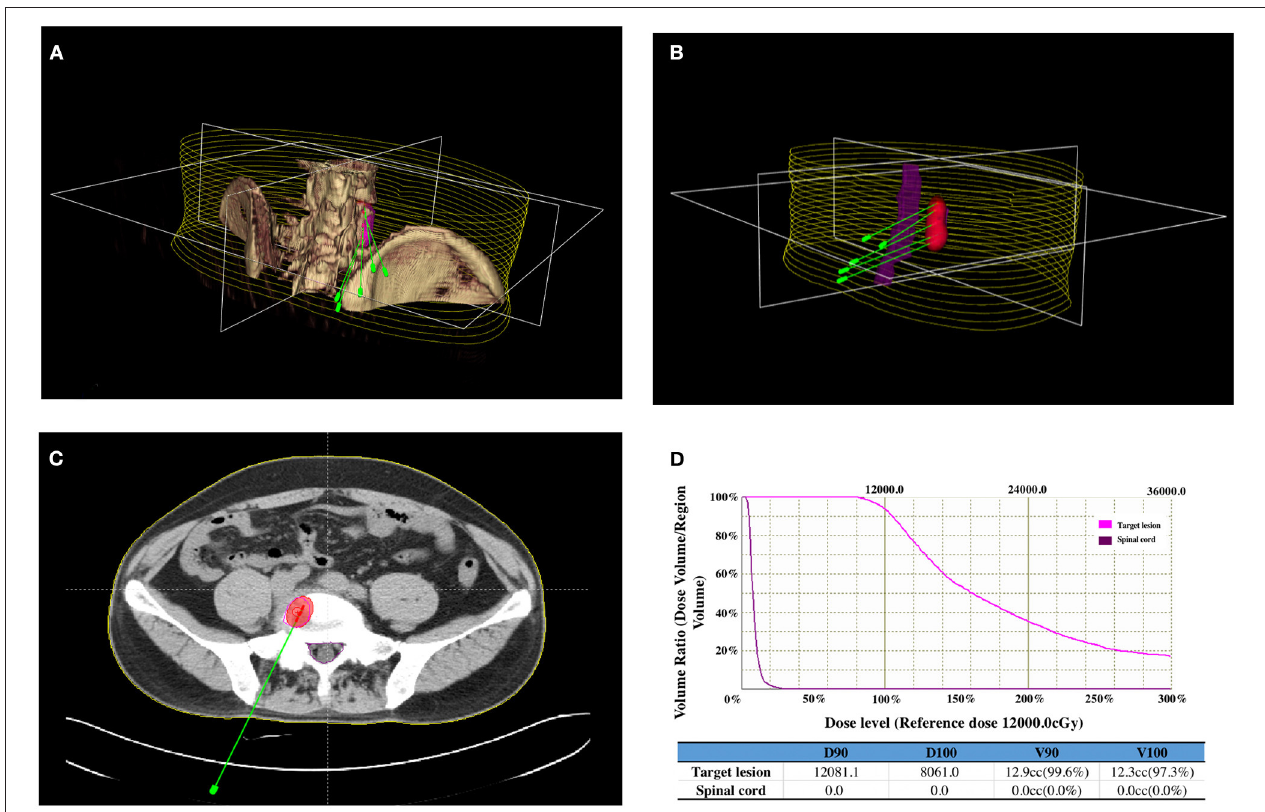
FIGURE 1 | Iodine-125 ( 125 I) brachytherapy treatment plan for bone metastases from breast cancer: (A) CT images of the lesion were reconstructed using a computerized treatment planning system (TPS), and the position of the brachytherapy applicators was calculated. (B) Three-dimensional image showing the relationship between the positions of the applicators, lesions, and spinal cord. (C) Two-dimensional image showing the irradiation dose (red area) of the 125 I brachytherapy field, tumor contour (purple line), and spinal cord (green line). (D) Dose-volume histogram indicating the prescribed dose to the lesion and the dose received by the spinal